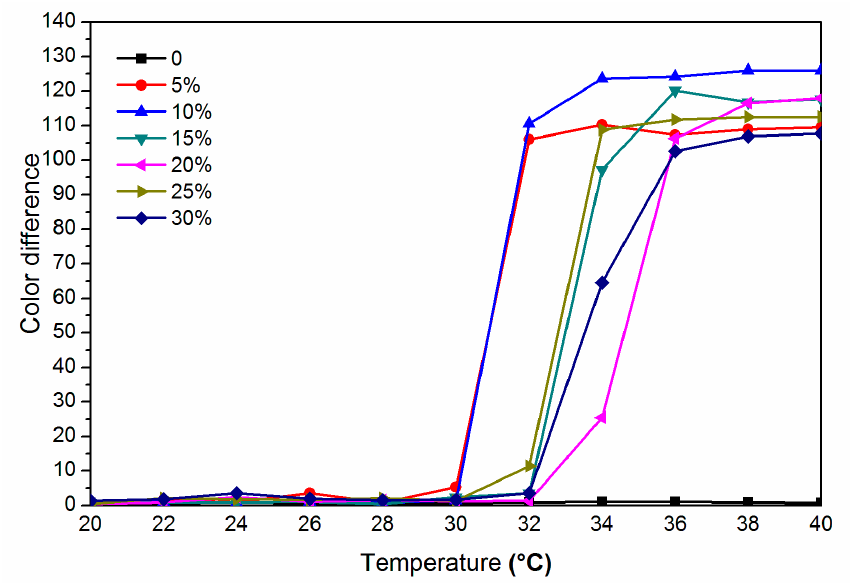
Figure 1. The e ff ect of concentration of thermochromic pigment powder on color di ff erence of Figure 1. The effect of concentration of thermochromic pigment powder on color difference of waterborne primer film from 18 to 40 ◦ C. waterborne primer film from 18 to 40 °C.